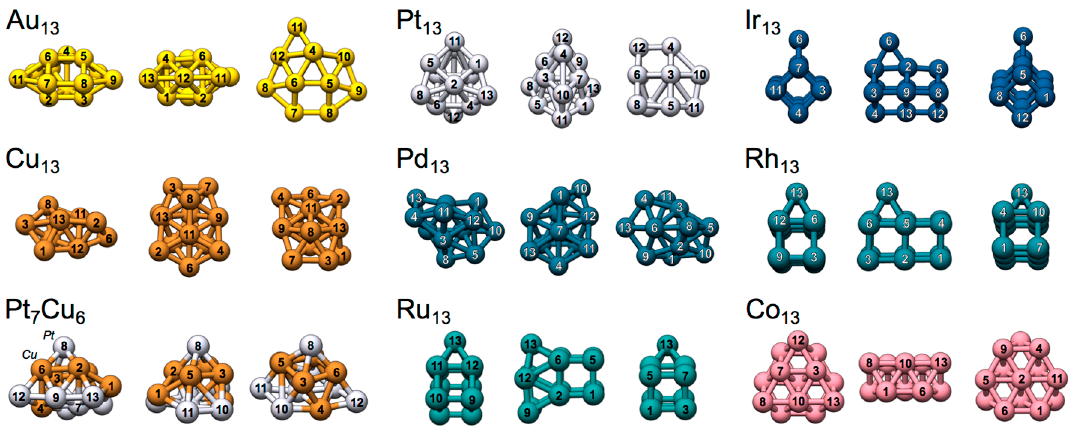
Figure 2 . Structures and atomic indexation of the TM 13 nanoclusters shown from different angles. Table 1. TM 13 nanocluster Schönflies symmetry group (Sym), ground-state spin multiplicity (2S + 1), and the number of unique atom binding sites (AS), as well as unique V S,max sites (VS) and E S,min sites (ES) identified on each cluster. Included are also the atom average valence s -, d - and p -occupations ( s -, d - and p -occ) as determined by NBO analysis [51].